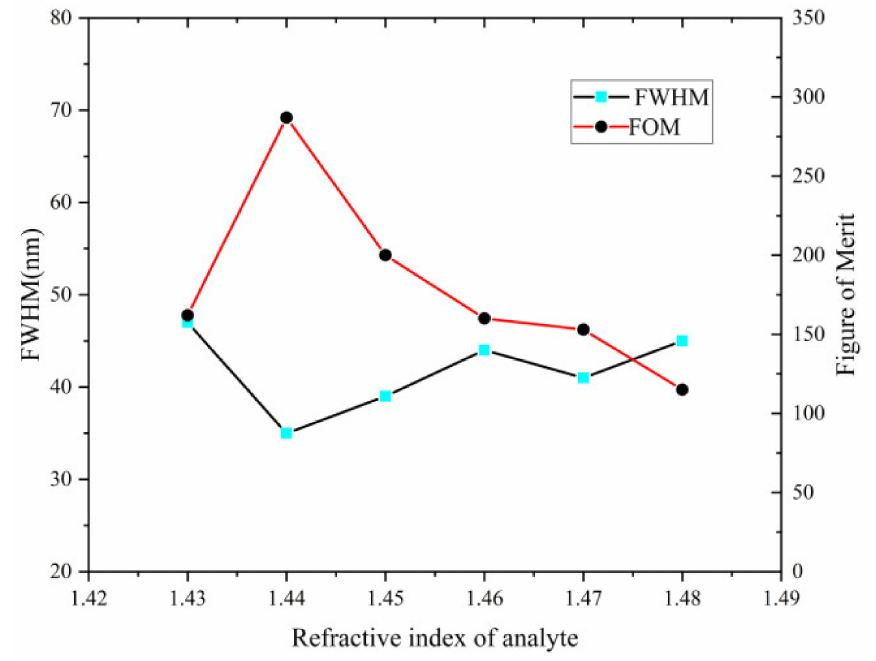
Figure 6. FWHM and FOM variation as a function of n a